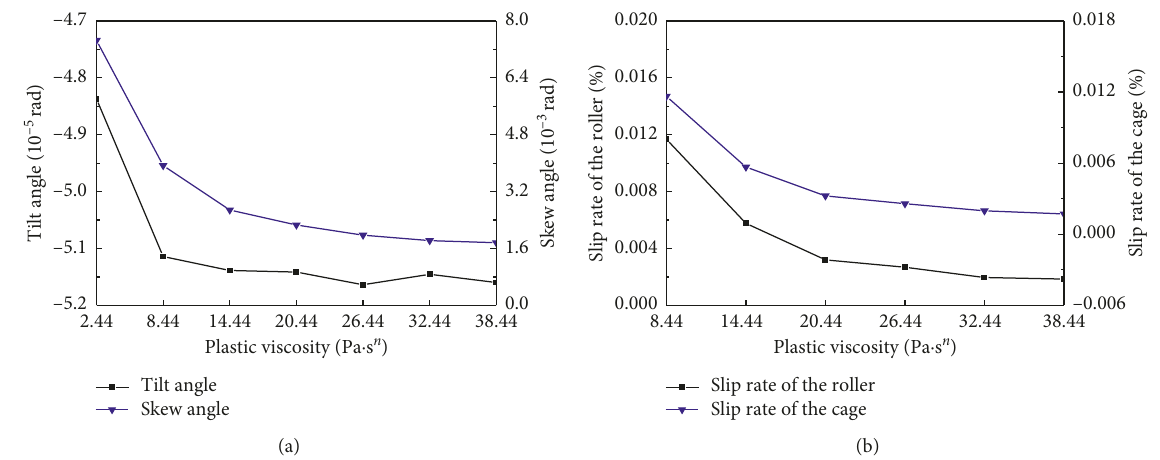
Figure 14: Plastic viscosity influence. F roller and cage.